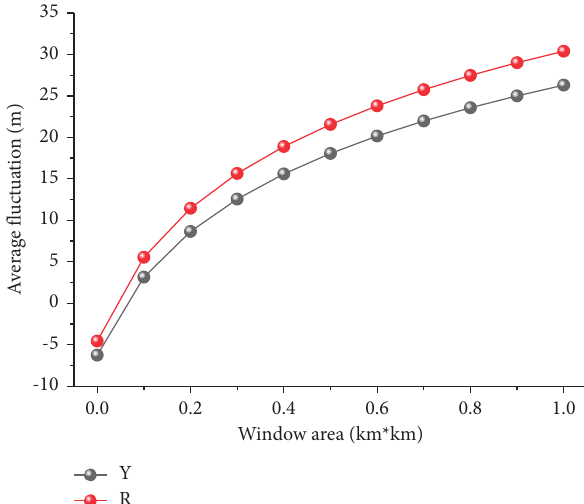
Figure 4: Precipitation on South Atlantic Ocean for different